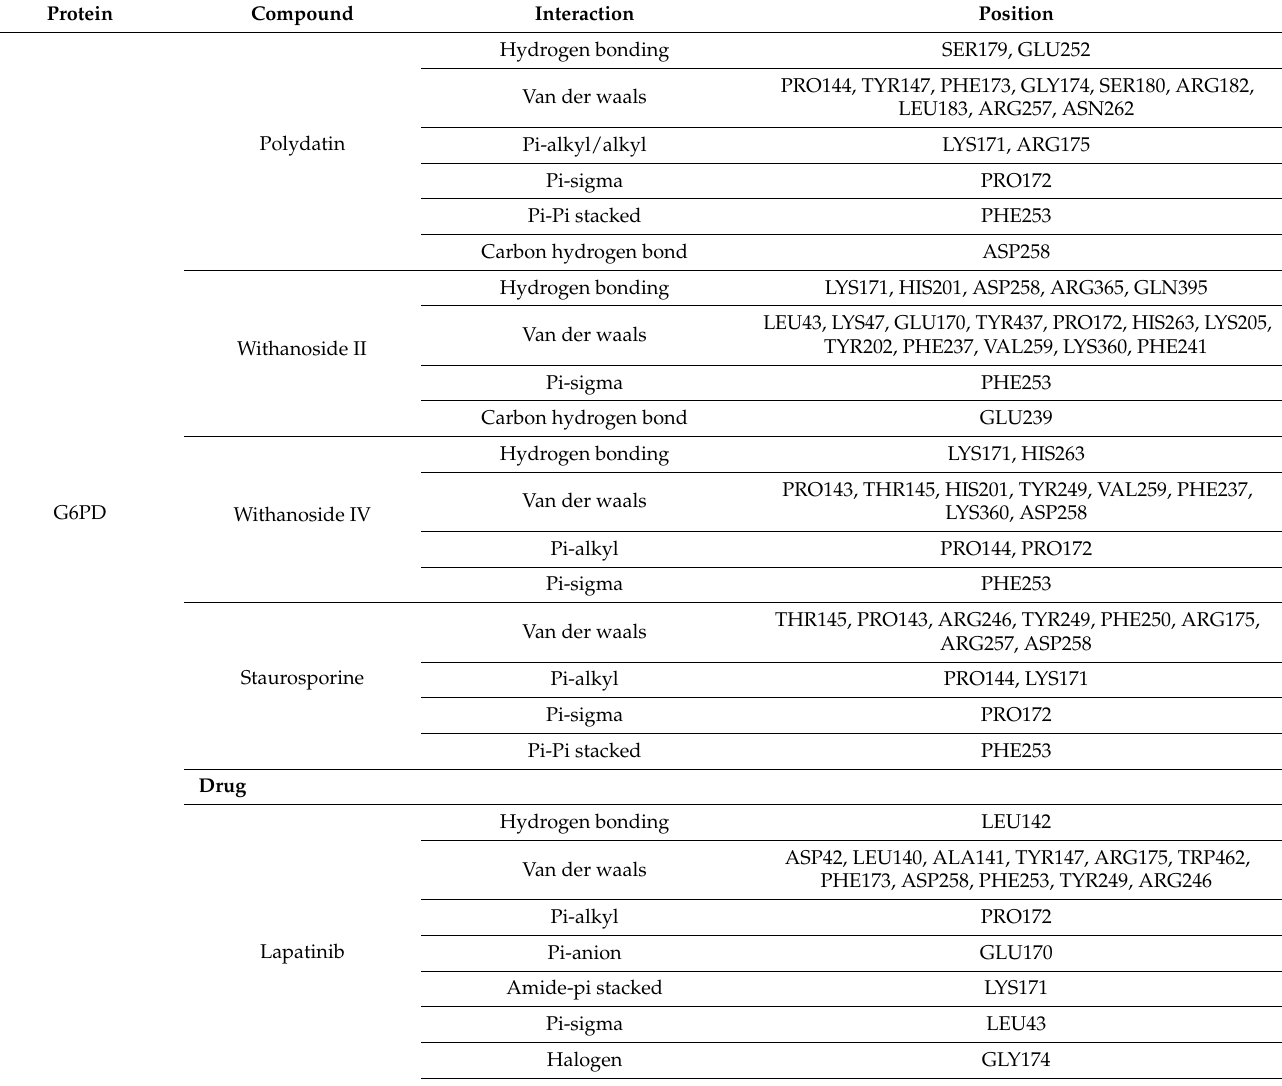
Table 2. Interaction and position of interacting residues between protein and compounds. Protein